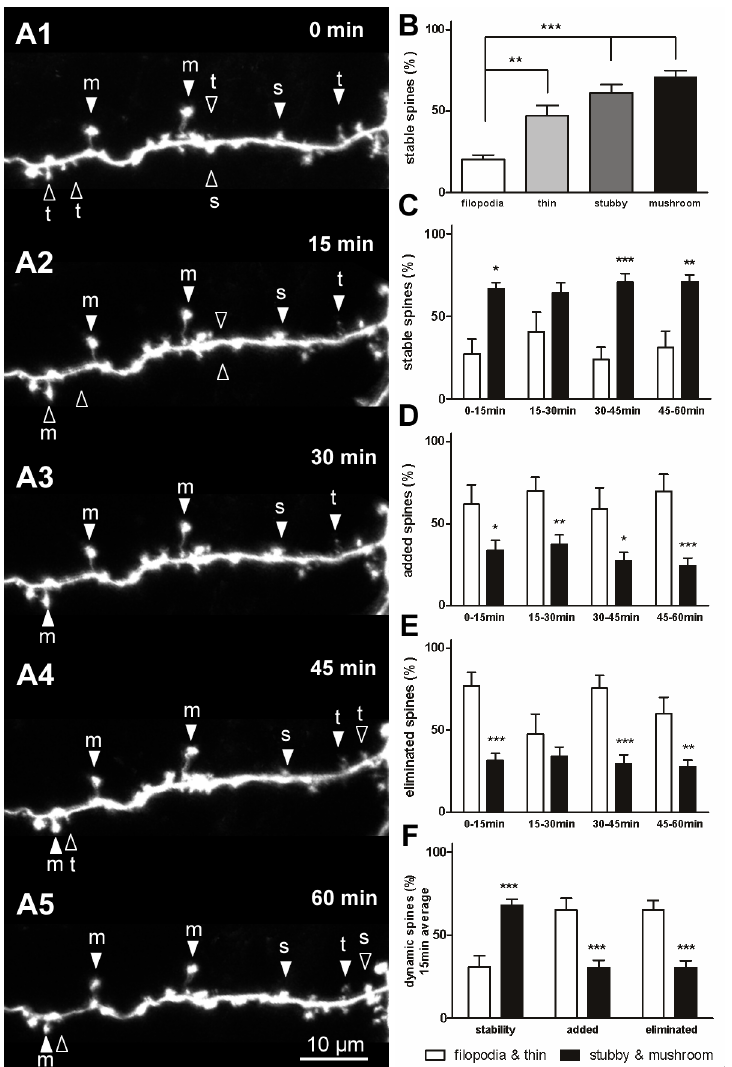
Fig 3. Stability and dynamics of dendritic spines during short-term observation. (A) Serial time-lapse images of a single neuron showing stable spines (filled arrowheads) and dynamic spines (open arrowheads) at 15-min intervals. (B) Stability of the 4 types of dendritic spines was observed at 15-min intervals. The stubby and mushroom spines were more stable than the filopodia and thin spines. (C) Detailed analysis of the stability of filopodia and thin spines versus stubby and mushroom spines at each 15-min interval observation. (D, E) Detailed analysis of filopodia and thin spines versus stubby and mushroom spines that were added (D) or eliminated (E) during each 15-min interval observation. (F) Average dendritic spine stability and dynamics at each 15-min observation. Bars indicate means ± SEM. N = 4 neurons with 9 dendrites were used for the 15-min short-term observation. Significance was set at * P < 0.05, ** P < 0.01, and *** P <